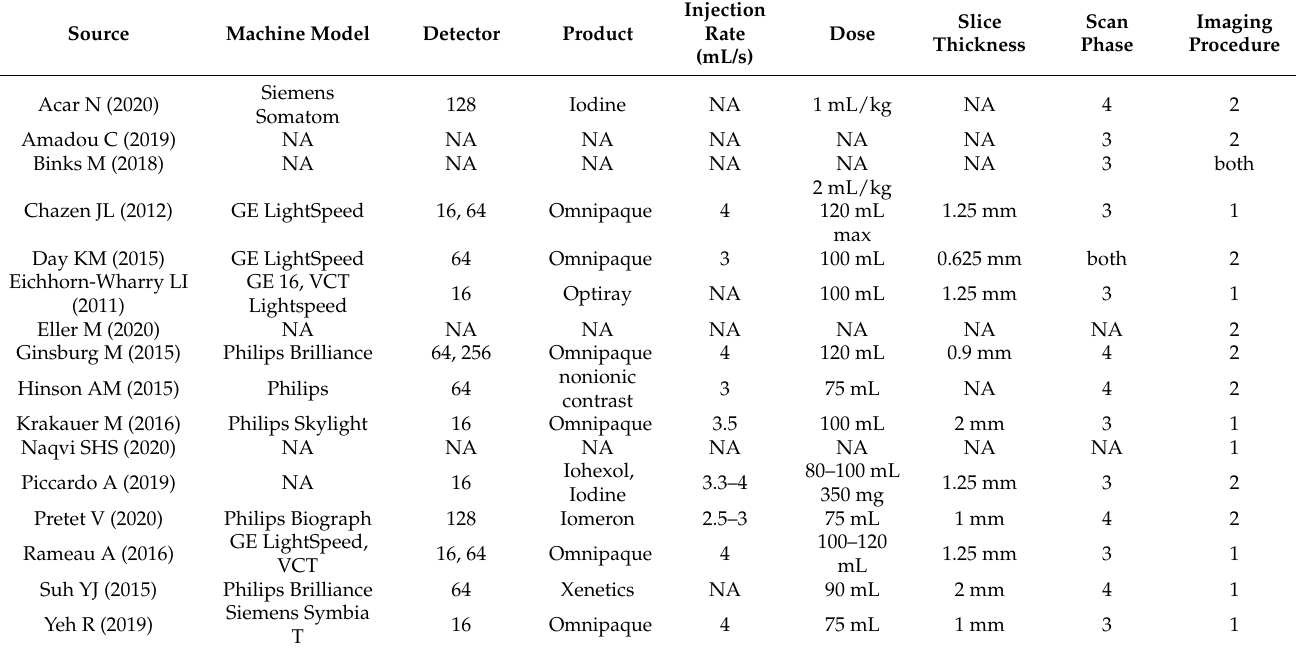
Table 2. Technical